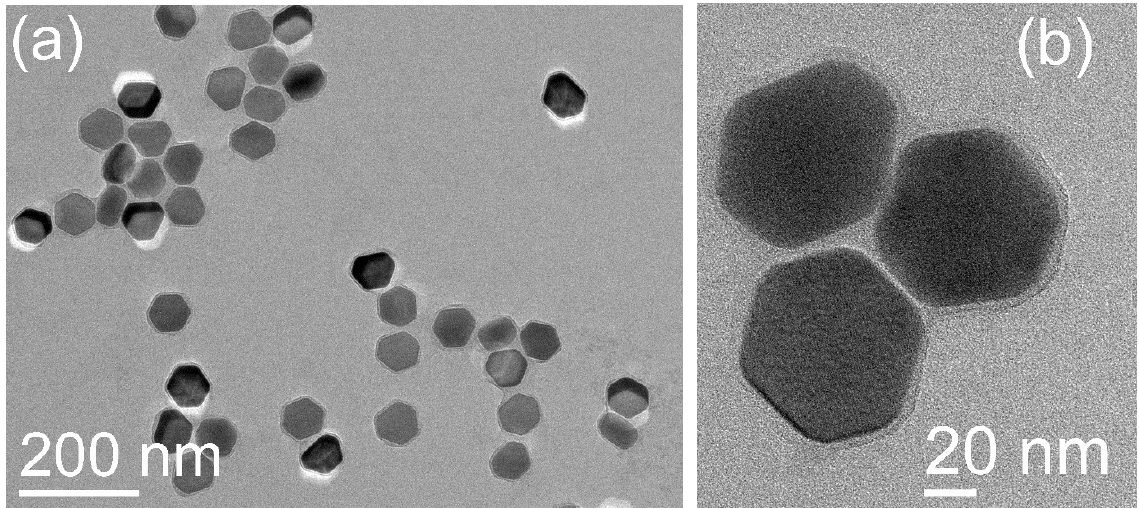
Figure S2. TEM images of the coated UCNPs @PB -150 : individual NPs (a) with an example of an NPs triplet, apparently glued together with an amorphous coating (b).